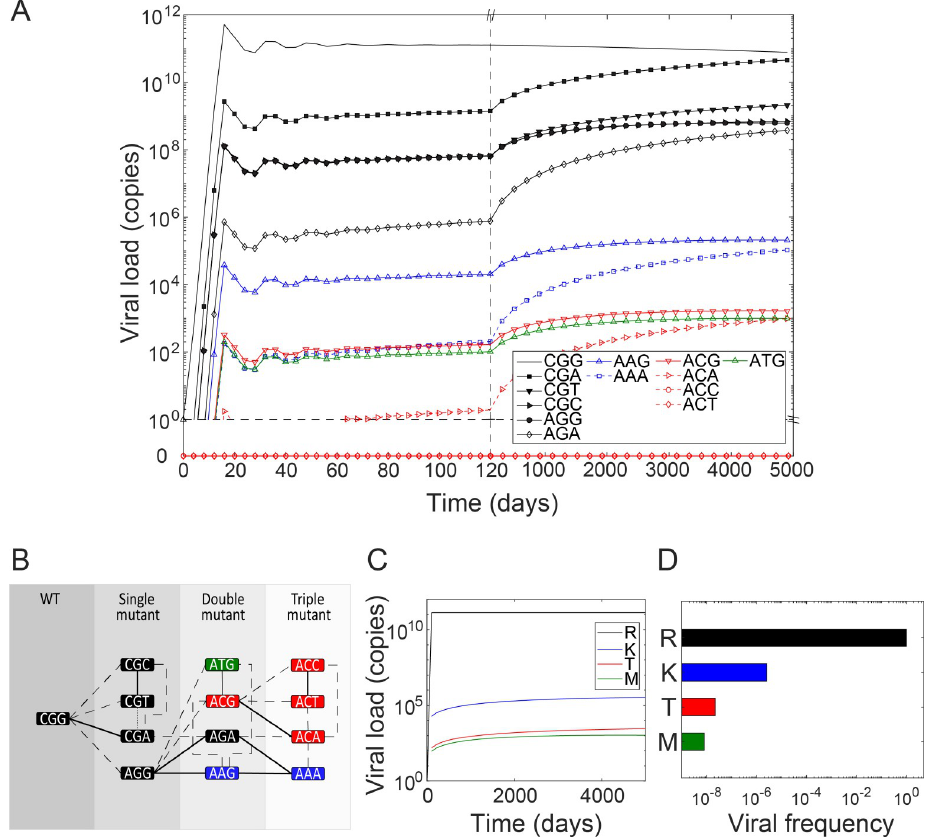
Fig 5. The mutant spectrum for HCV genotype 1b. (A) The time-evolution of population of virions carrying different codons, color coded by the amino acids they encode. (B) The mutational pathway map with CGG, the wild- type codon for HCV genotype 1b at position 155 of the NS3 protein, as the founder. Transitions are in solid lines and transversions in dashed lines. The lines connect codons separated by a single mutation. The shades of grey indicate the number of mutations from the infecting strain, CGG. (C) The time-evolution of variants grouped by amino acids. (D) The corresponding frequencies of the different variants.